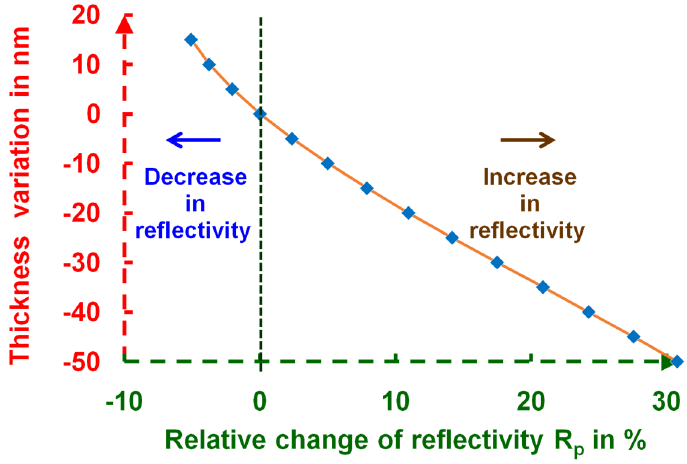
Figure 15. Thickness variations due to the viscosity of the ormosil layer.( a ) Relative thickness gaps between day 0 and day 38. These gaps are due to the viscosity of the 40 wt.% PDMS-based ormosil thin film. The pink line represents the axis of the study depicted in Figure 17. ( b ) Thickness map of the relative thickness gaps between day 0 and day 38.